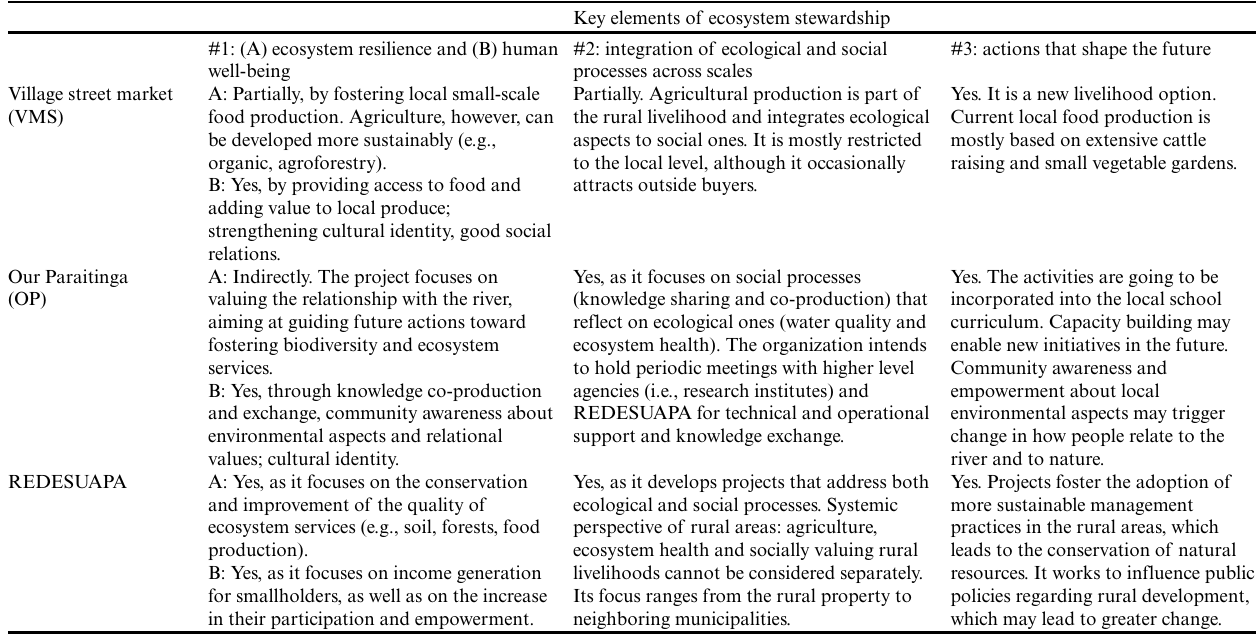
Table 3 . Three environmental initiatives in the municipality of São Luiz do Paraitinga, southeast Brazil, encompassing the key elements of ecosystem stewardship (sensu Chapin et al. 2015). REDESUAPA = Portuguese acronym for The Upper Paraíba River Sustainable Development